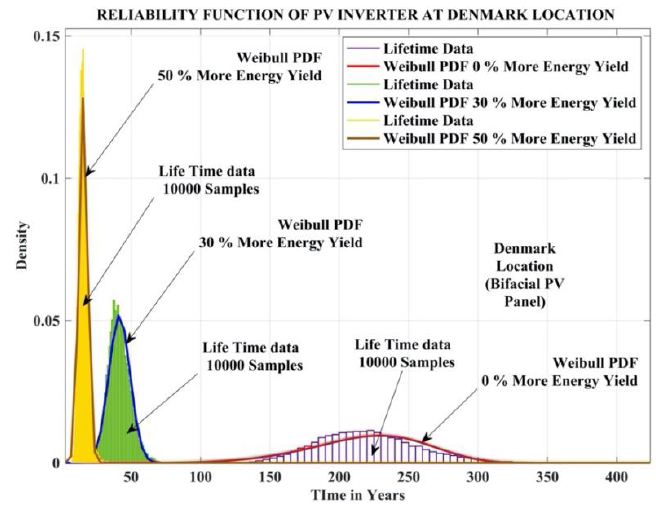
Figure 20. Lifetime distribution of the PV inverter at the location in Denmark.